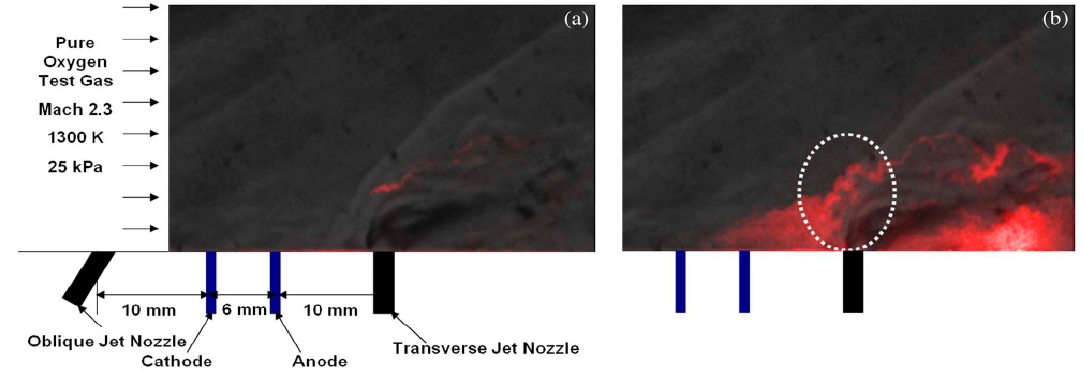
Figure 6. The OH PLIF images overlapped with a typical schlieren image of the same flow condition: ( a ) without plasma; ( b ) in the presence of the plasma [87], (the figure is courtesy of Dr. Hyungrok Do). In this test, the flow/injection conditions were found for both H 2 and C 2 H 4 injection, when a stable ignition/combustion was realized with plasma on while it was not detected without plasma.